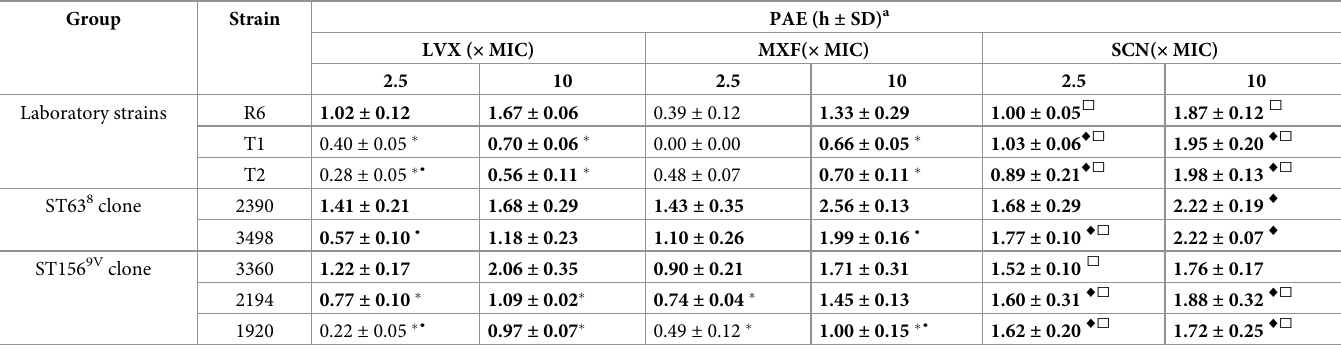
Table 2. PAE in planktonic S . pneumoniae strains after 1 h exposure to drugs, measured by viable count method. Group